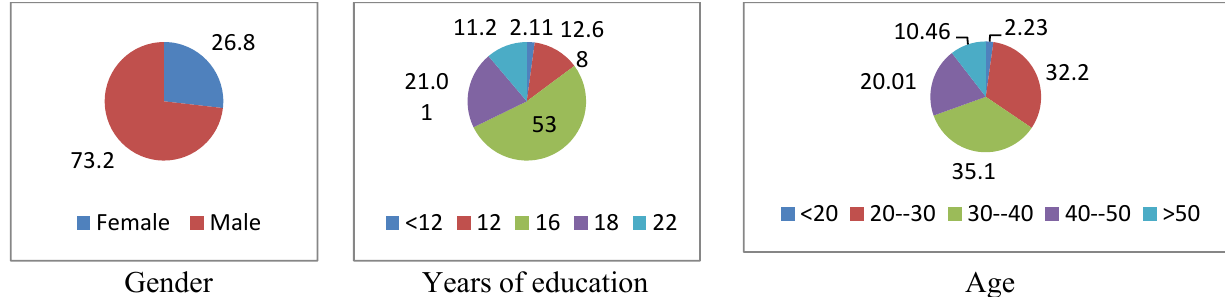
Fig. 1. Personal characteristics of the